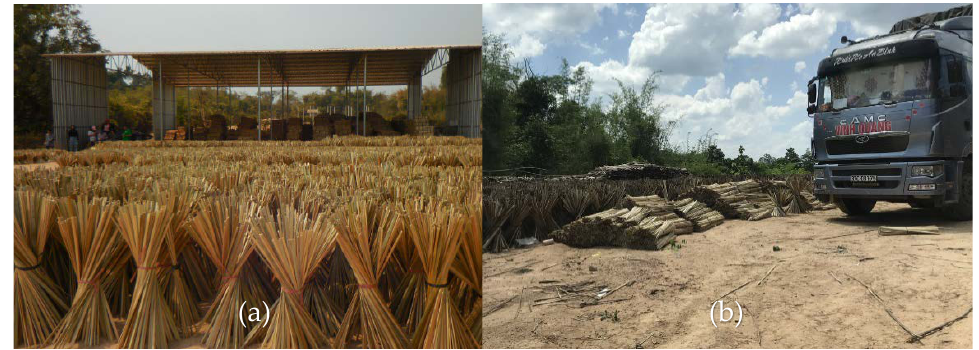
Figure 4. Bamboo collection and management: ( a ) air drying bamboo splits and ( b ) loading bamboo splits into a truck owned by a Vietnamese company.